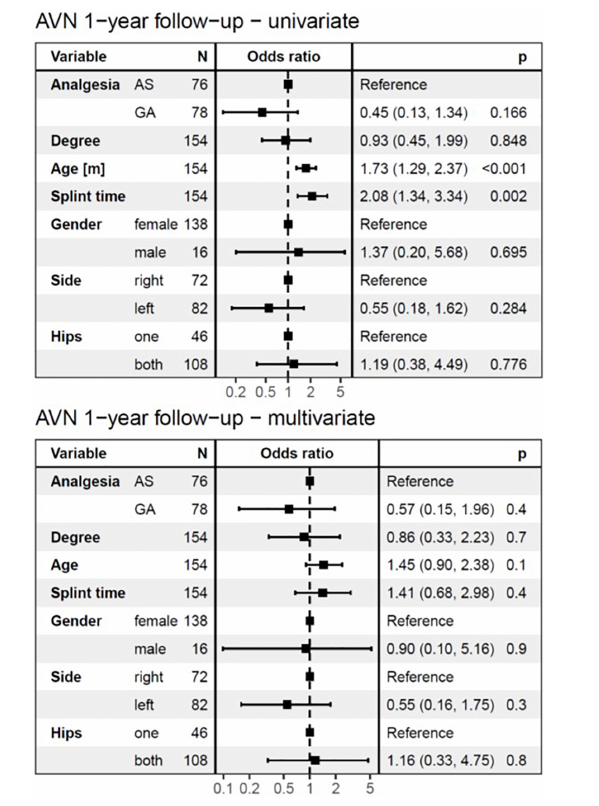
FIGURE 4 | The logistic regression model at 1-year follow-up. The univariate analysis showed no significant difference in the development of AVN between AS and GA groups and identified age at diagnosis and splint time as substantial risk factors. In the multivariate analysis, none of the independent variables showed a significant influence on the development of AVN at 1-year follow-up. AVN, avascular necrosis; AS, analgesia and sedation; GA, general anesthesia; N, number of affected hips.